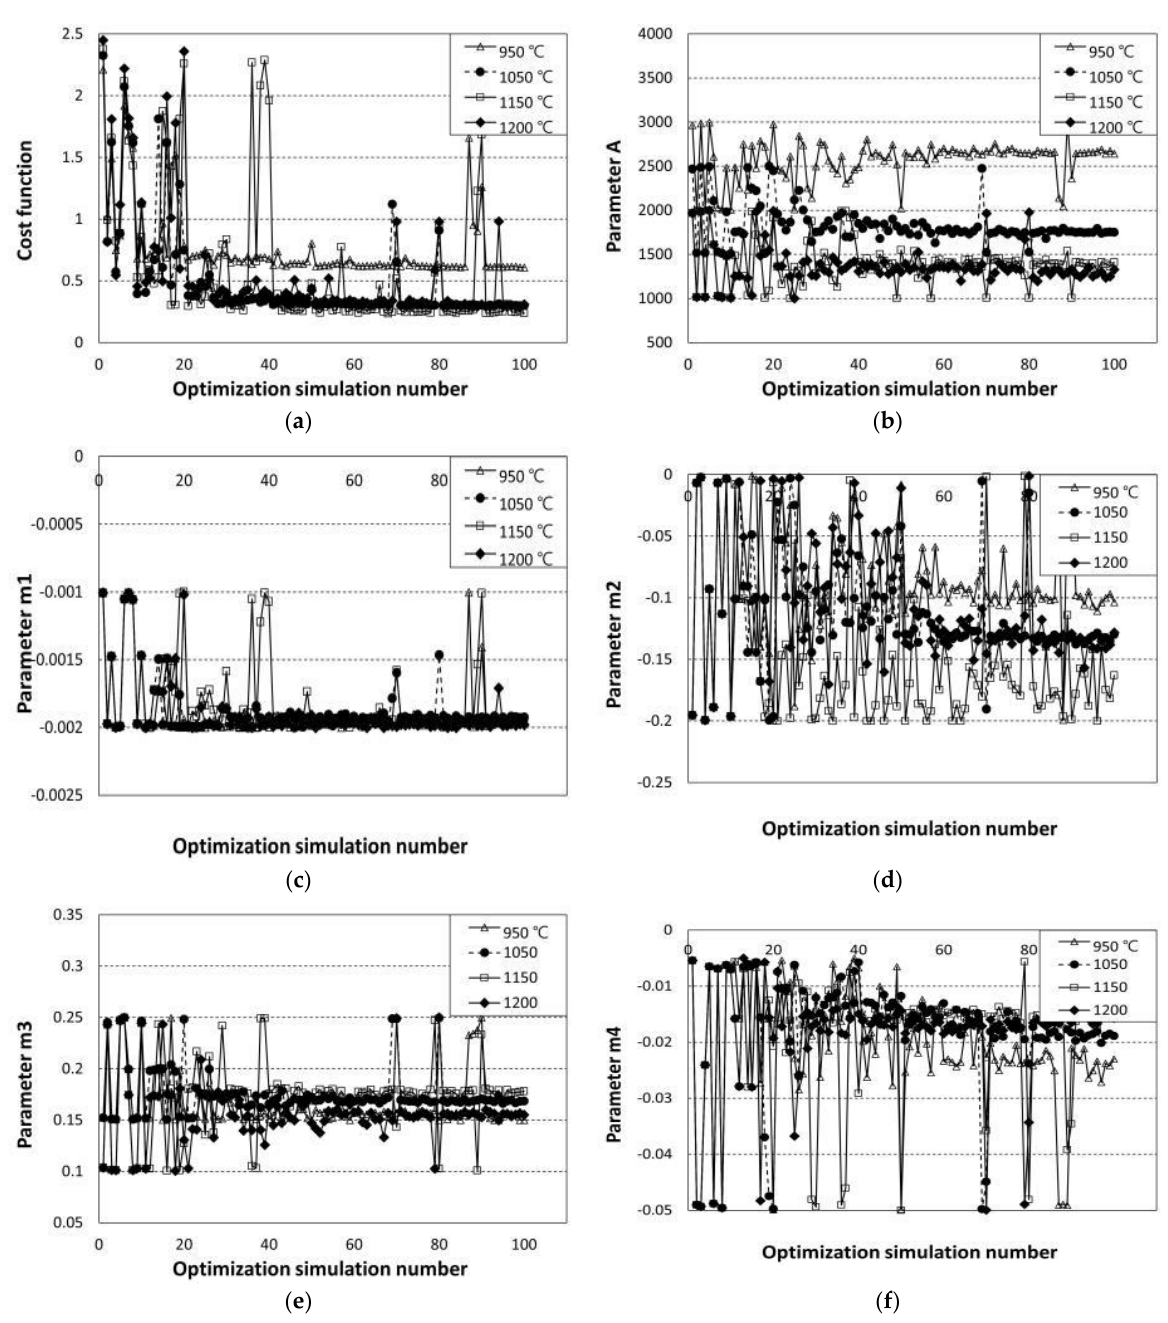
Figure 9. Changes in cost function and parameters during optimization: ( a ) cost function, ( b ) A, ( c ) m 1 , ( d ) m 2 , ( e ) m 3 , and ( f ) m 4